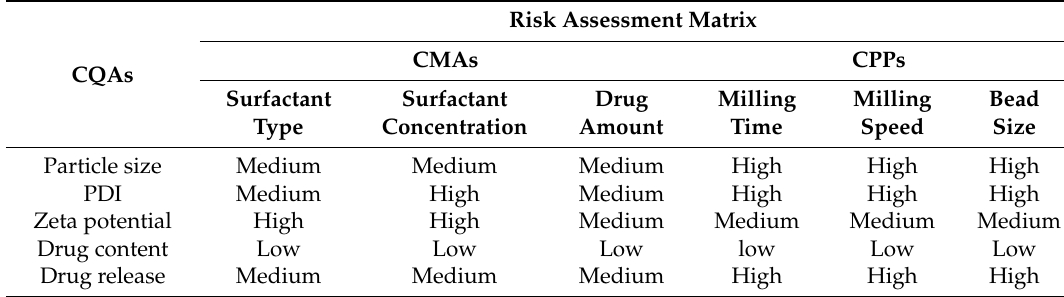
Table 4. Example of risk assessment matrix for drug nanocrystals analyzing the impact of critical material attributes (CMAs) and critical process parameters (CPPs) on product attributes: case study for drug nanocrystals. Modified from